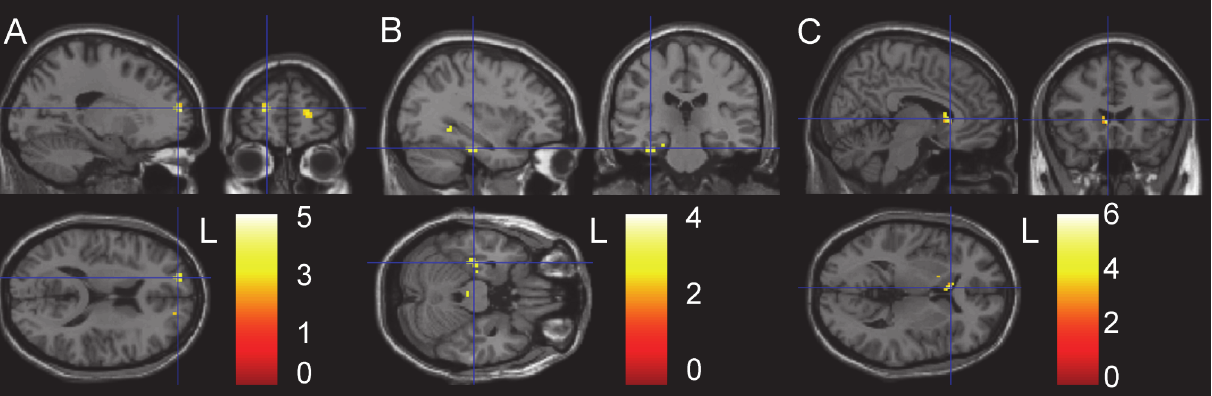
Figure 2. Effects of TSD for fMRI and [ 11 C]raclopride PET. p < 0.005, extent threshold 10 voxels. A and B are task related fMRI results, showing increased prefrontal and limbic activation respectively, in the conditions (A) positive valence versus baseline and (B) both emotional valences. C is a [ 11 C]raclopride PET image, showing decreased voxel-by-voxel RPM2 binding potential (BP ND ) in nucleus caudatus in n = 8. At the bottom right is the Z-score scale depicted.